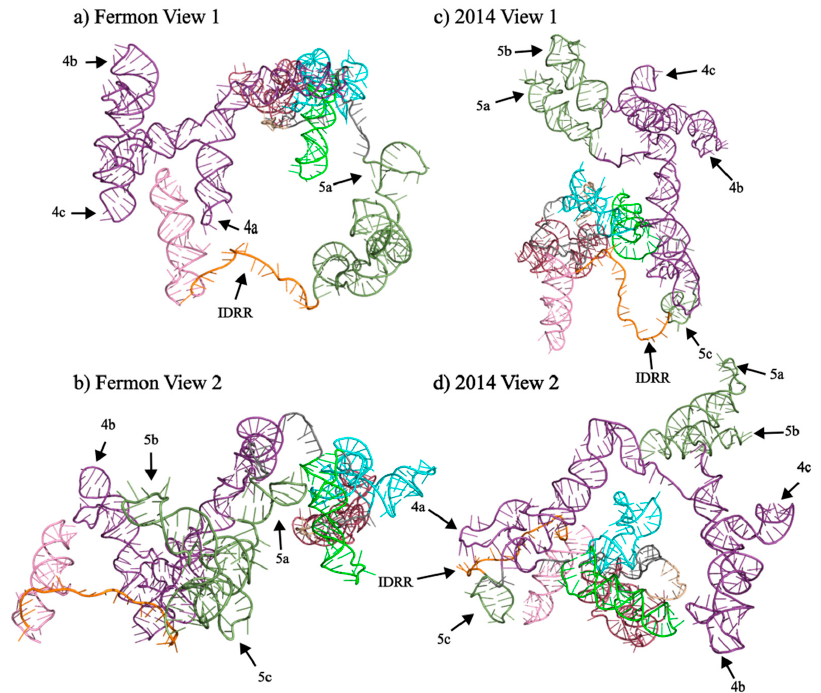
Figure 7. Tertiary structures domains IV and V of EV-D68 Fermon and 2014 Strains. Panels ( a – d ) represent the tertiary structure predictions generated using 3DRNAv2.0 for domains IV and V of the 5 ′ UTRs of the Fermon and 2014 strains. Structural predictions were visualized and pseudocolored using PyMOL. The coloring of the domains follows the pattern set in Figure 1. Structures of interest are labeled within each panel. Panels ( b ) and ( d ) represent the Fermon and 2014 5 ′ UTR structures, respectively, viewed from a different angle. Whereas domain IV in the two strains shows common elements that are important for IRES function, several details of the long, extended helix differ markedly between the strains. Most prominently, two stem-loops that are generally grouped in domain V, and do indeed appear in domain V in the Fermon strain, have been subsumed into domain IV in the 2014 strain. This creates a IV/V super domain in the 2014 strain that greatly extends the length of domain IV. As would be expected, the formation of the IV/V super domain significantly impacts the model of the tertiary structure of the domain IV elements (Figure 7). Domain IV of the Fermon strain extends away from the majority of the molecule and has stems 4a and 4c associated with stem 5d of domain V. However, in the 2014 strain, domain IV takes on a different conformation, with stems 4b and 4c located closer to domains II and III, while stem 4a is located near the IDRR and stem 5c of domain V. Despite this, stems 4b and 4c are still separated from the rest of the molecule. 3.5. Domain V The structure of domain V in the 2014 strain is significantly impacted by the for- mation of the domain IV/V Super domain. In the Fermon strain, domain IV ends near position 440, which begins the transition into domain V. In the 2014 strain, position 440 is part of the stem-loop we label as 5a. A second stem-loop, labeled as 5b, as well as nucleo- tides that form the closing helix of the super domain, are part of the expanded domain IV.